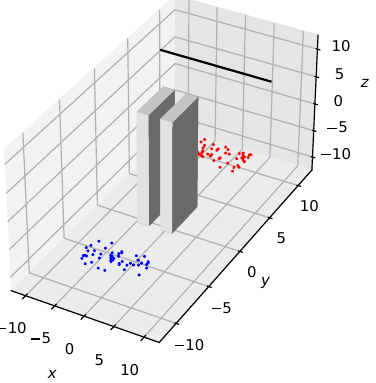
Figure 3. The 3D attack and defense experimental